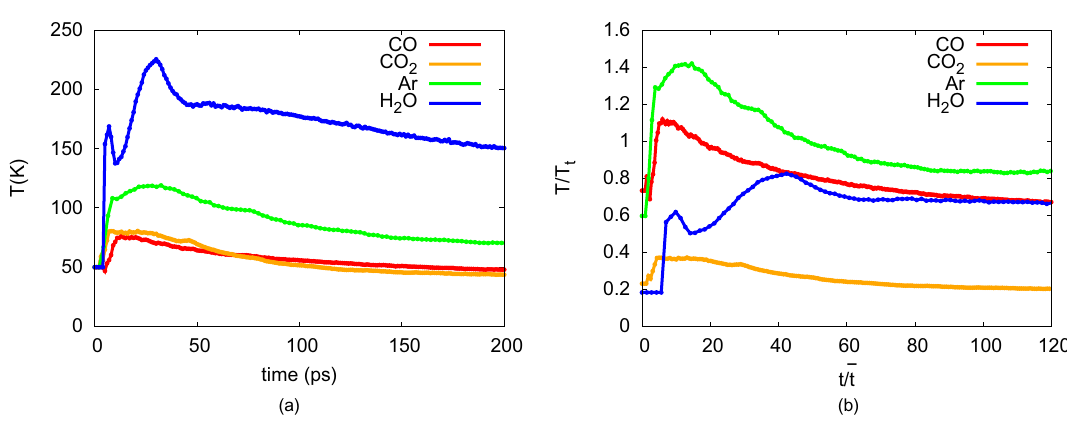
Figure 4. Evolution of the contact area for NP collisions with the species indicated with scaled time, t /